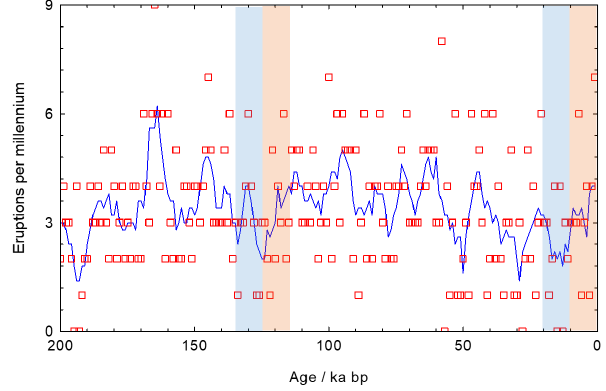
Figure 6. Cumulative eruption numbers over the past 200kyr recorded in the Dome C ice core for different eruption deposition fluxes of sulfate. Periods of deglaciation are marked with a blue bar and interglacials with an orange bar.